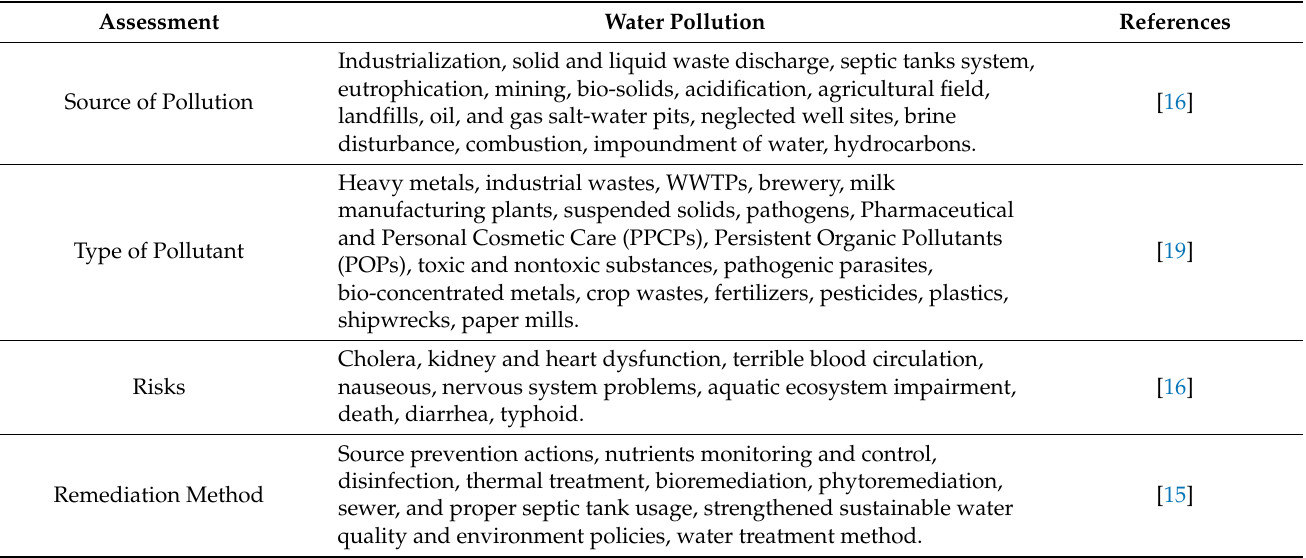
Table 2. The environmental assessment of water